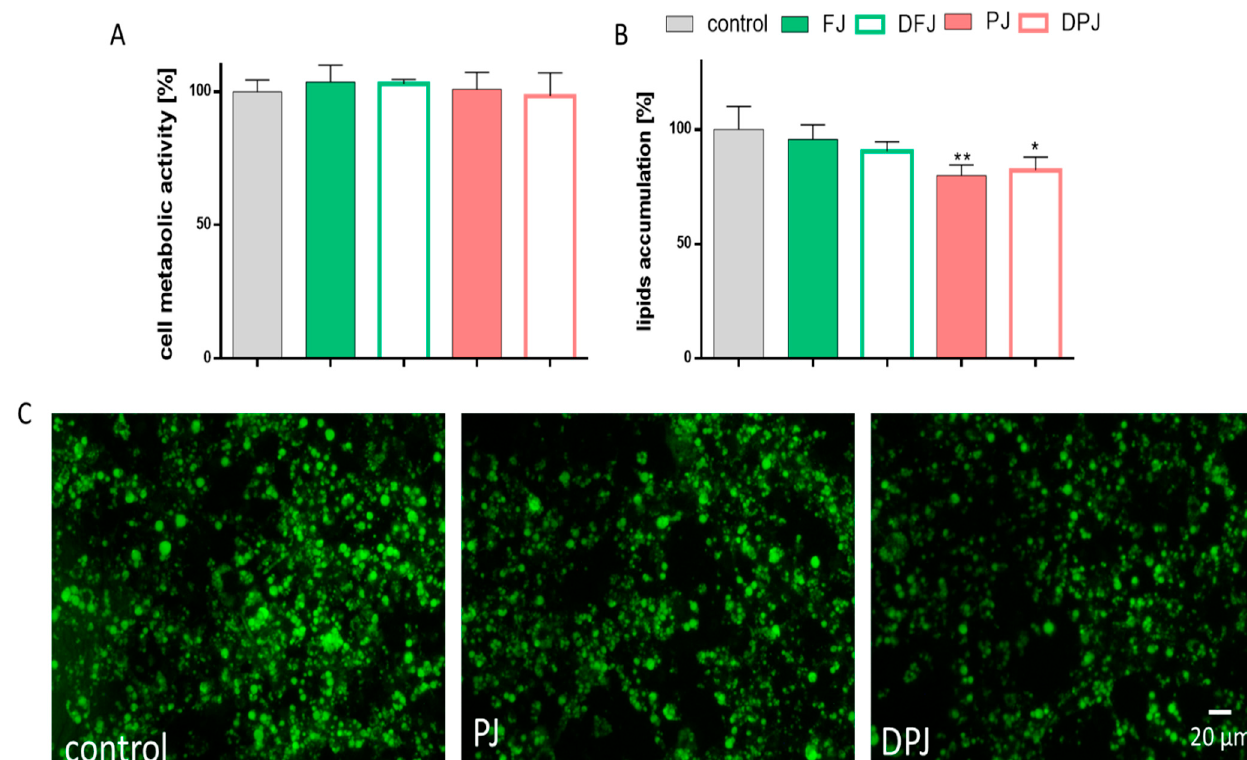
Figure 7. The influence of V. opulus fresh juice (FJ), digested fresh juice (DFJ), purified juice (PJ), and digested purified juice (DPJ) at non-cytotoxic concentration (IC 0 ) on differentiated 3T3-L1 cells’ metabolic activity after 7-day incubation ( A ); the accumulation of lipid droplets ( B ); control cells were not exposed to any compound except vehicle; values are means ± standard deviations from at least three independent experiments, n ≥ 9; statistical significance was calculated versus control cells (untreated), * p ≤ 0.05, ** p ≤ 0.01. Cells visualized under fluorescent microscope at 200× magnification with FITC filter after Nile red staining ( C ).